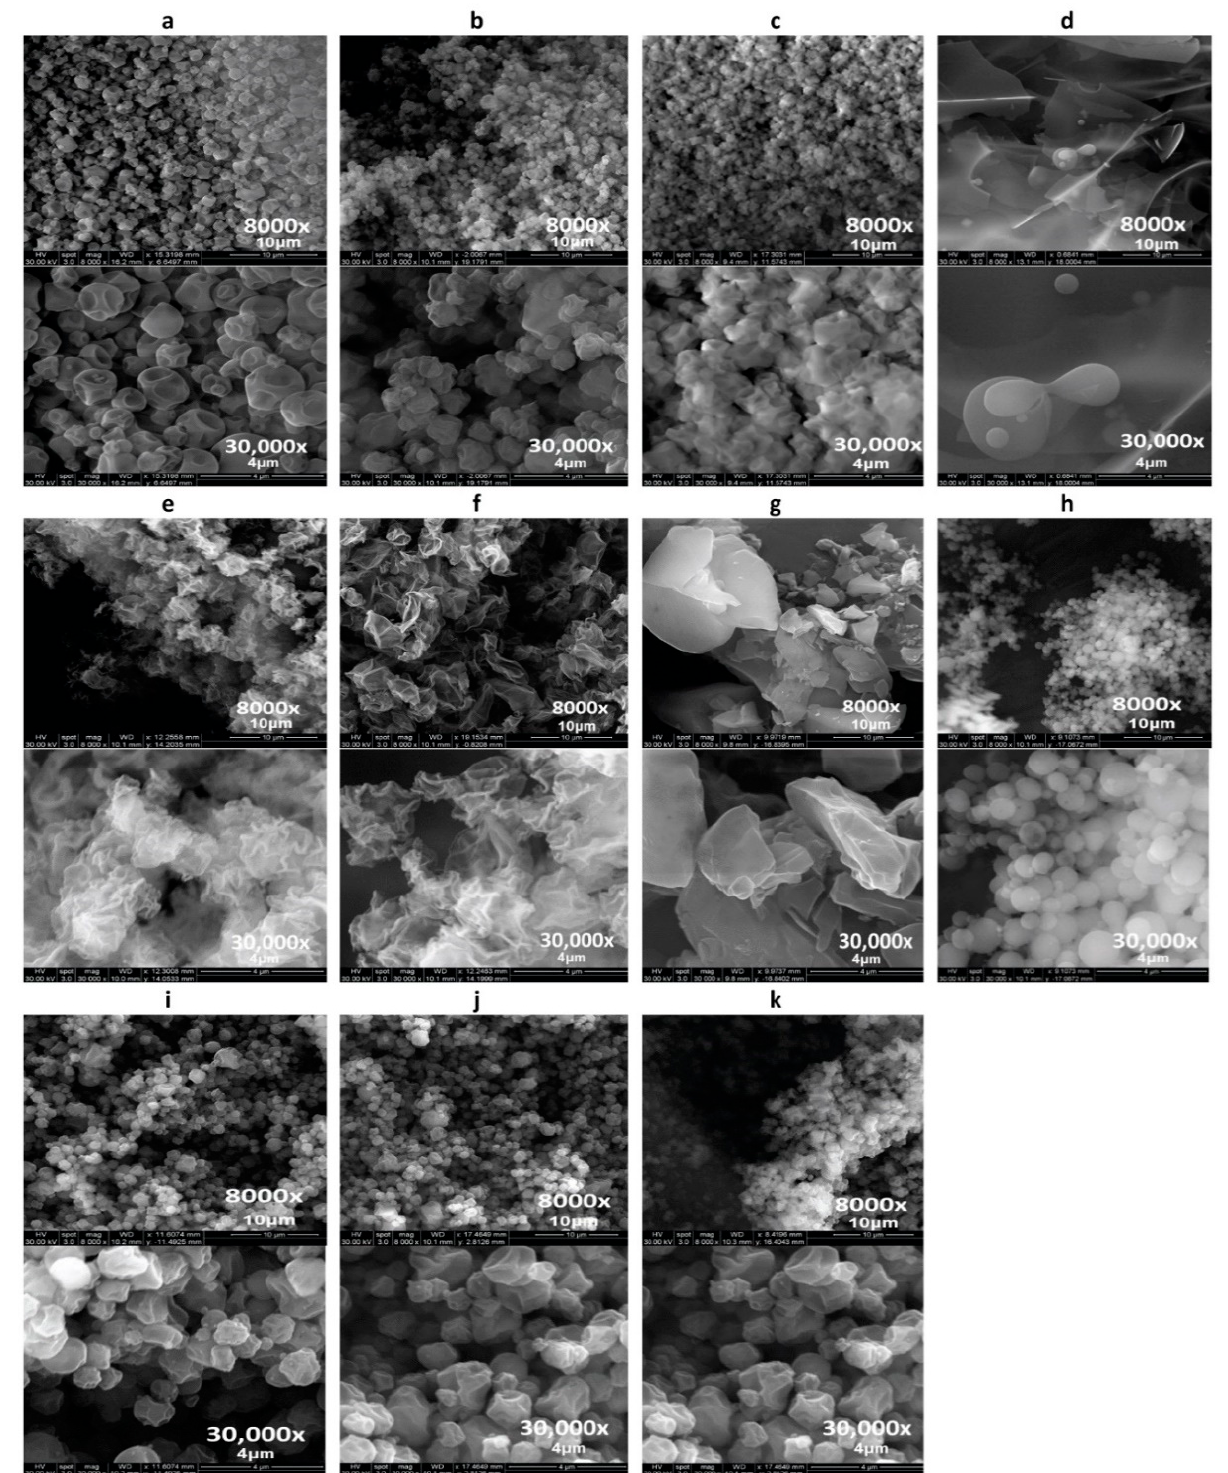
Figure 2. SEM micrographs at two magnifications (8000 × and 30,000 × ) for each sample: ( a ). Raw Lactomorphin as supplied by the manufacturer; ( b ). SD-Lactomorphin in MeOH at 25% PR; ( c ). SD-Lactomorphin in MeOH at 50% PR; ( d ). SD-Lactomorphin in MeOH at 75% PR; ( e ). SD-Lactomorphin in EtOH at 25% PR, ( f ). SD-Lactomorphin in Isop at 25% PR; ( g ). Raw Trehalose as supplied by the manufacturer; ( h ). SD-Trehalose in MeOH at 25% PR; ( i ). Co-SD-Lactomorphin:Trehalose 25:75 in MeOH at 25% PR; ( j ). Co-SD-Lactomorphin:Trehalose 50:50 in MeOH at 25% PR; and ( k ). Co-SD-Lactomorphin:Trehalose 75:25 in MeOH at 25% PR.